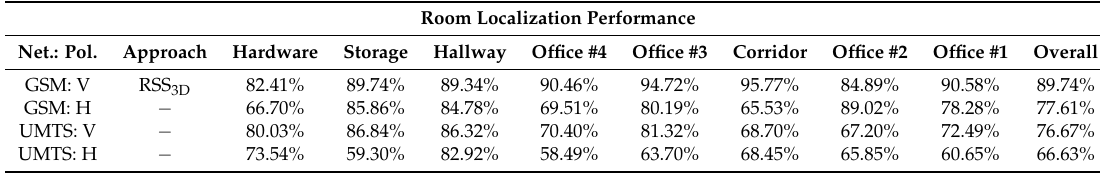
Table 3. Experimental W K NN Room Localization Performance for 3D